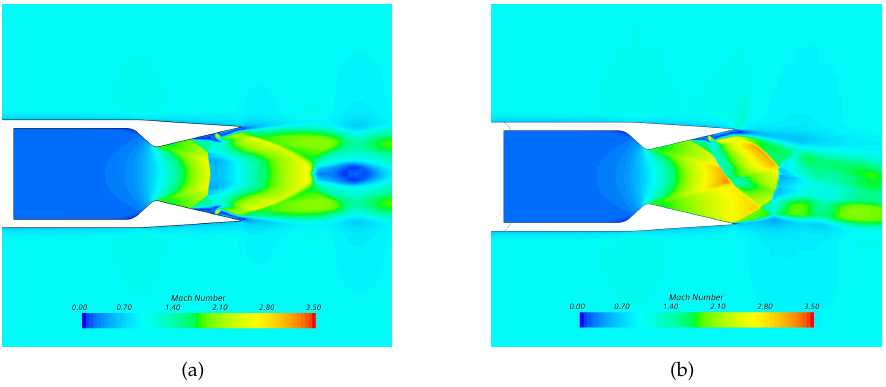
Figure 12. Comparison between the axisymmetric ( a ) and three dimensional ( b ) solution of the simulation with secondary